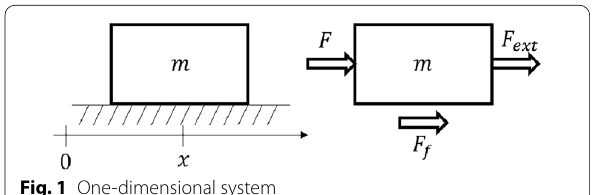
Fig. 1 One‑dimensional system